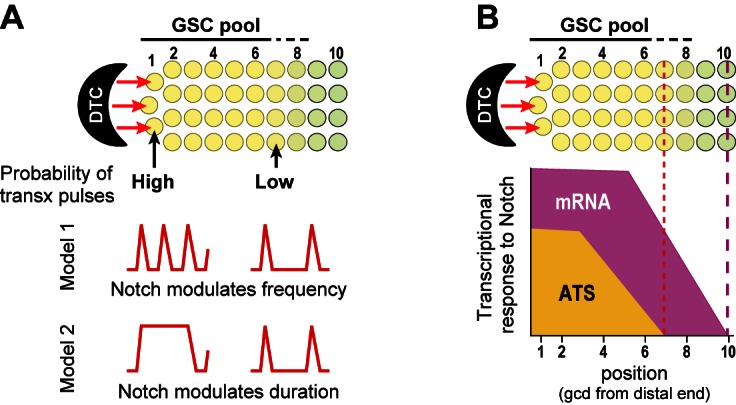
Gradient of Notch-dependent active transcription sites: models for underlying mechanism (A) and relation to mRNA distribution (B).(A,B) Top, Notch signaling from the DTC niche maintains a pool of germline stem cells (GSCs) (Cinquin et al., 2010). (A) Notch signaling generates a gradient in the probability of transcriptional activation across the stem cell pool. ATS probability differences may result from modulation of ATS frequency (Model 1) or duration (Model 2). Red lines illustrate theoretical effects on transcriptional bursting at high (left) or low (right) probability. (B) Notch signaling from niche generates differently-shaped gradients of ATS and mRNA: mRNA abundance is essentially ungraded in the region where ATS probability is graded; the mRNA gradient extends further proximally than the ATS gradient; and more cells have mRNAs than ATS at any given position.